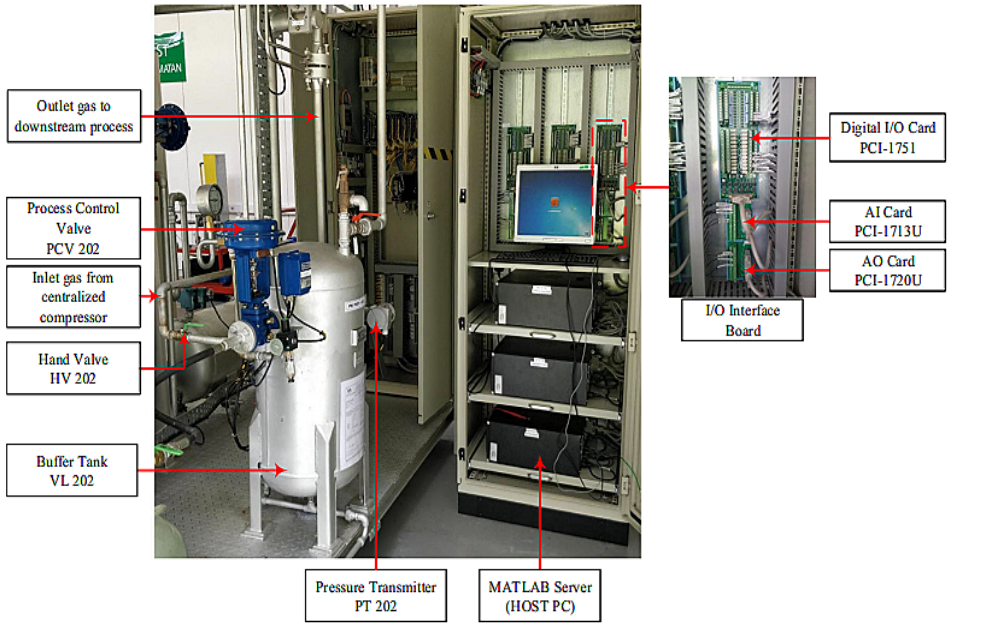
Figure 2. Single-tank pilot plant setup for data